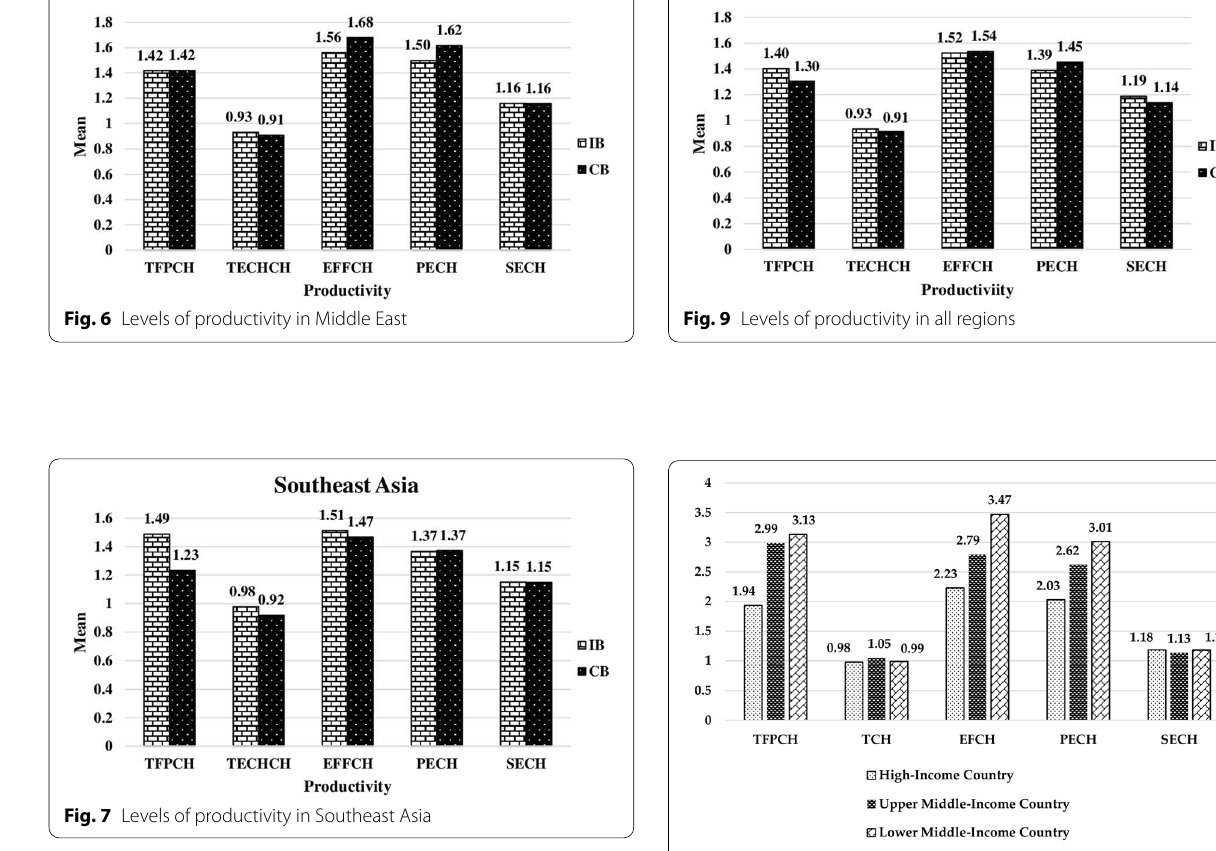
Fig. 10 TFPCH for Islamic Banks in Different Income Groups from Year 2008 to